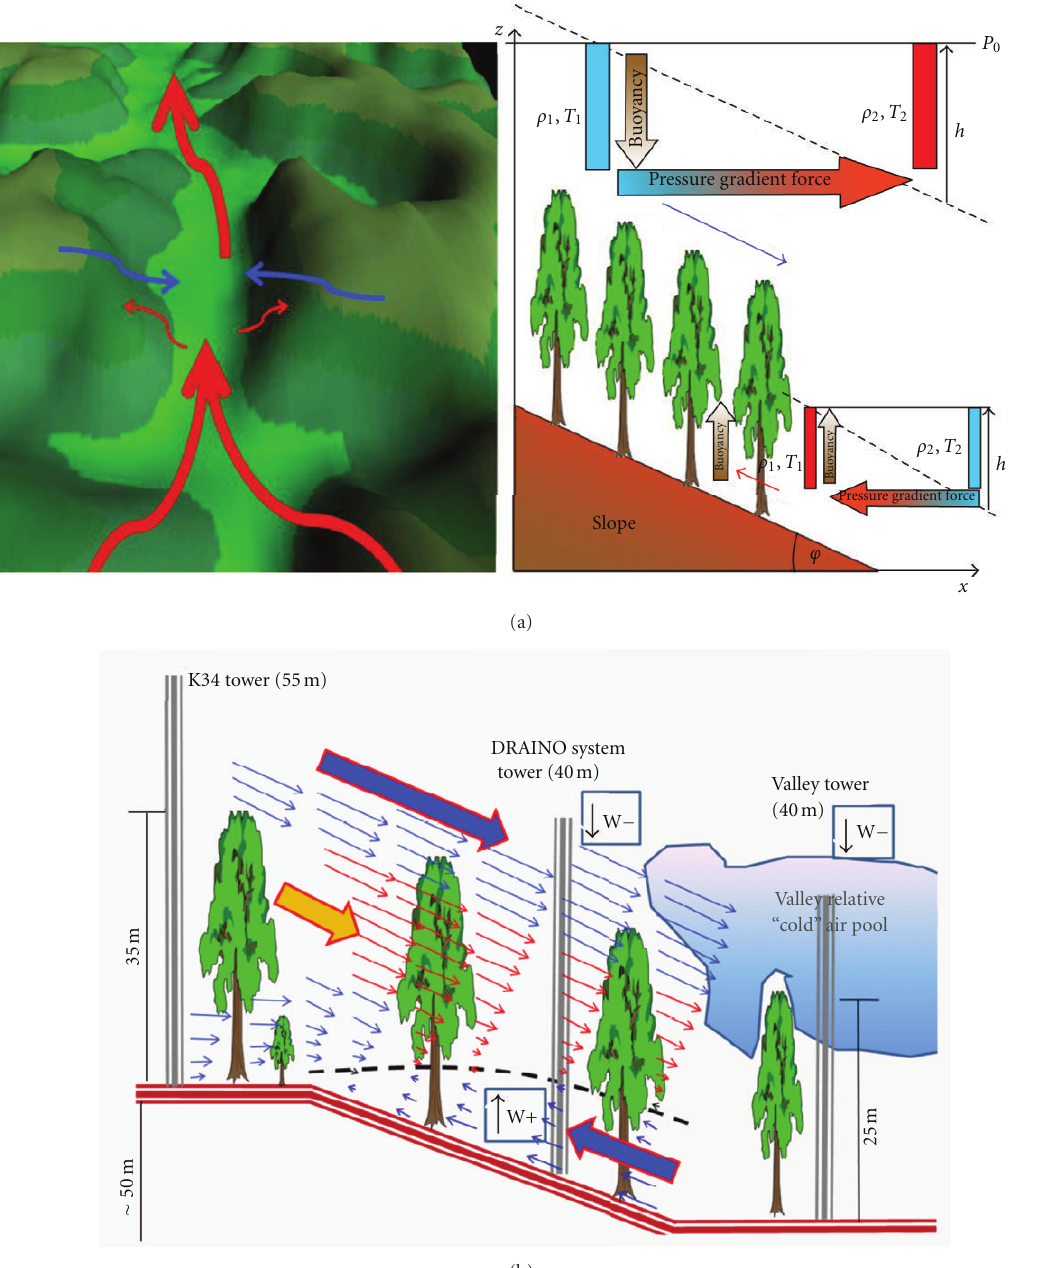
Figure 15: Schematic local circulations in the site studied, valley and slopes flow (a), 2D view from suggested below and above canopy airflow